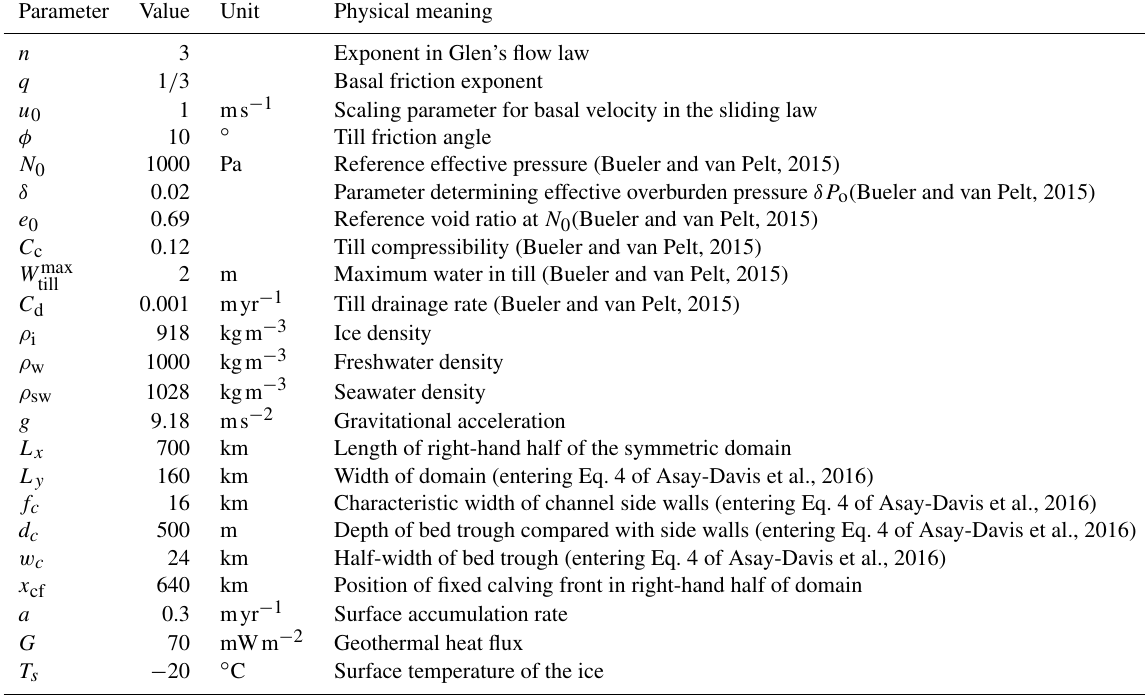
Table 1. Physical constants and model parameters